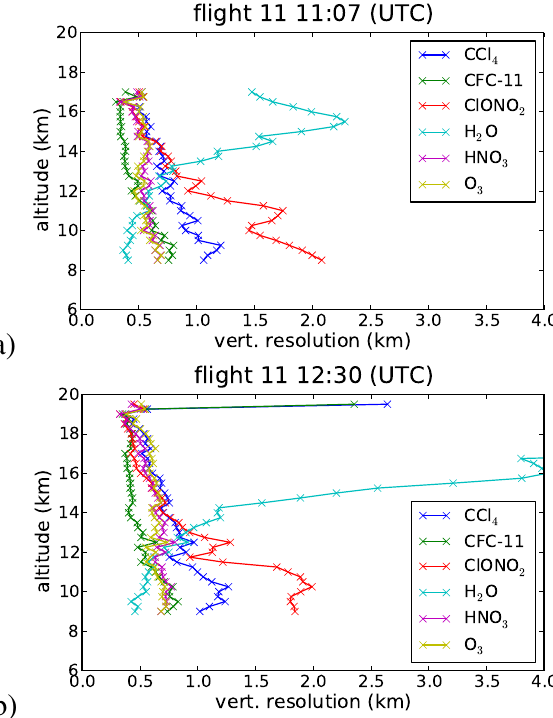
Fig. 8. Vertical resolution for CCl 4 and CFC-11, ClONO 2 , H 2 O, O , HNO , H , and O for profiles at 2 2 3 3 HNO 3 and O 3 for profiles at 11:07 in (a) and 12:30UTC in (b)